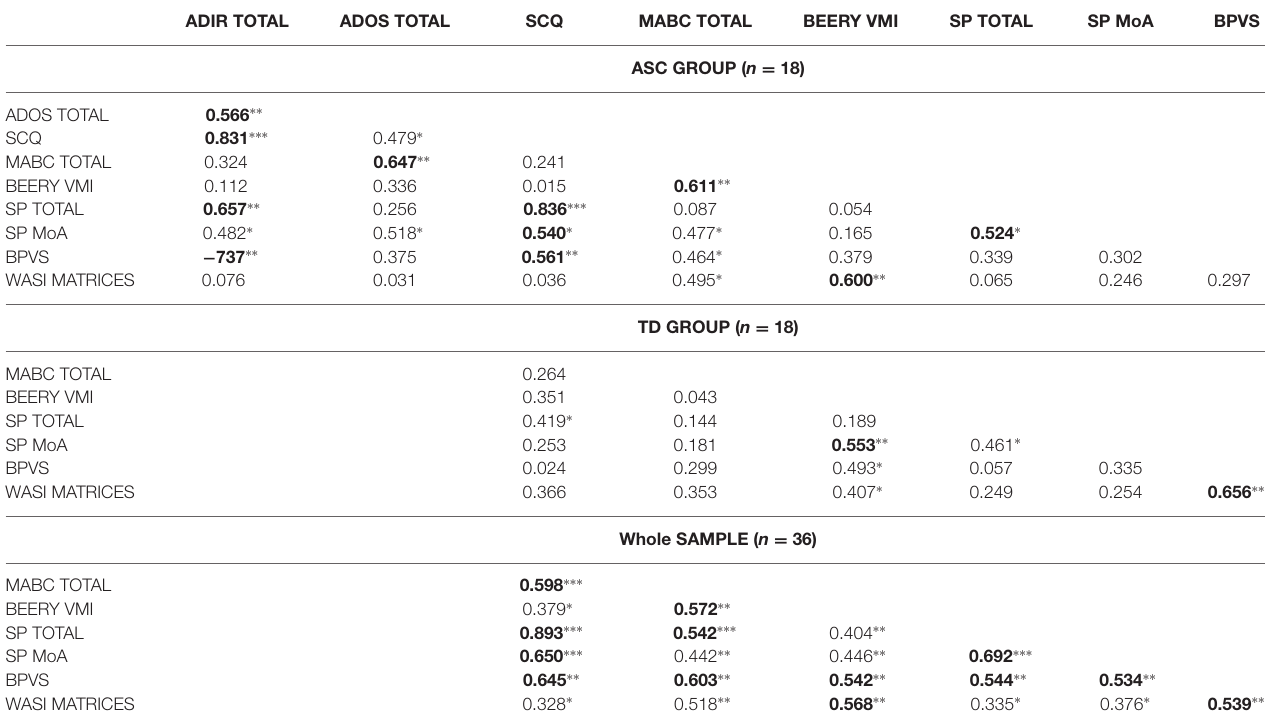
TABLE 3 | Correlation analysis ( r ) for autism symptom measures, coordination and sensory responsivity in autism spectrum conditions (ASC), typically developing (TD) and combined ASC and TD group. ADIR